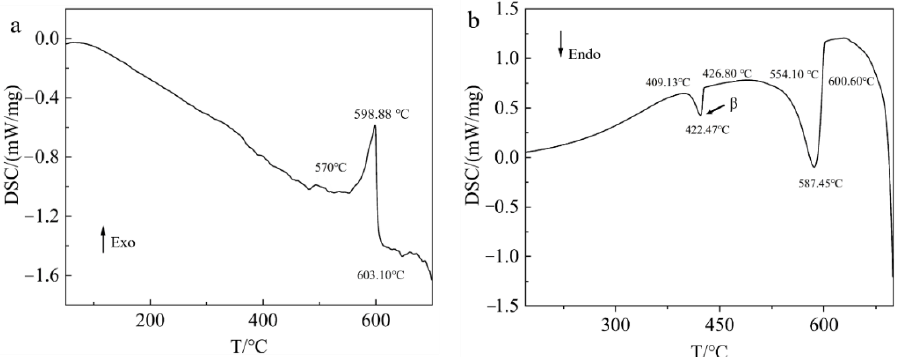
Figure 4. DSC curves of SLMed AZ61 magnesium alloy: ( a ) heating curve; ( b ) cooling curve.